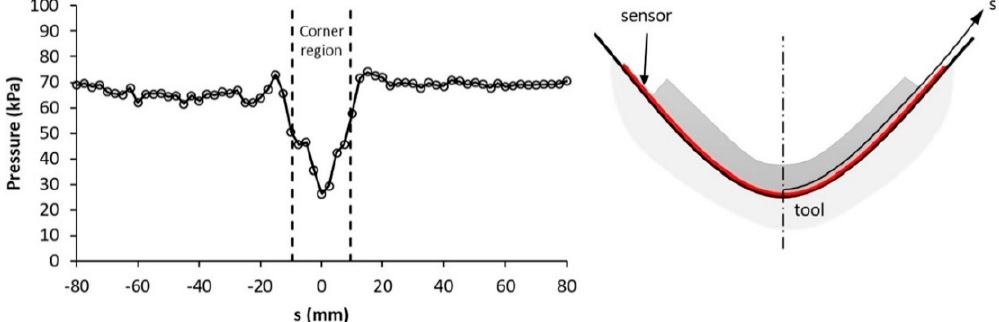
Figure 1. Pressure profile for a concave-cornered laminated composite produced using VBO [34] .